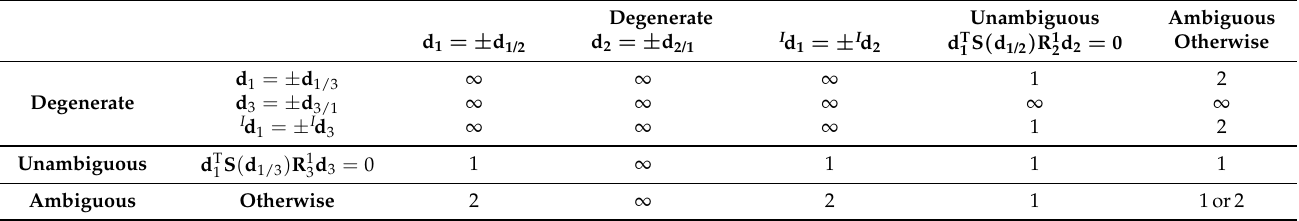
Table 1. Number of solutions for the entire